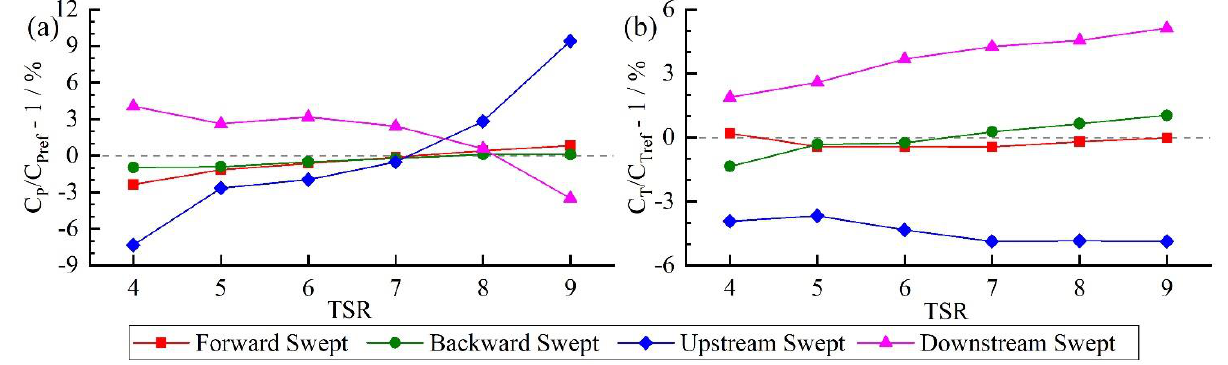
Figure 7. Variation in C P and C T due to swept blades; (a) for C P , and (b) for C T .